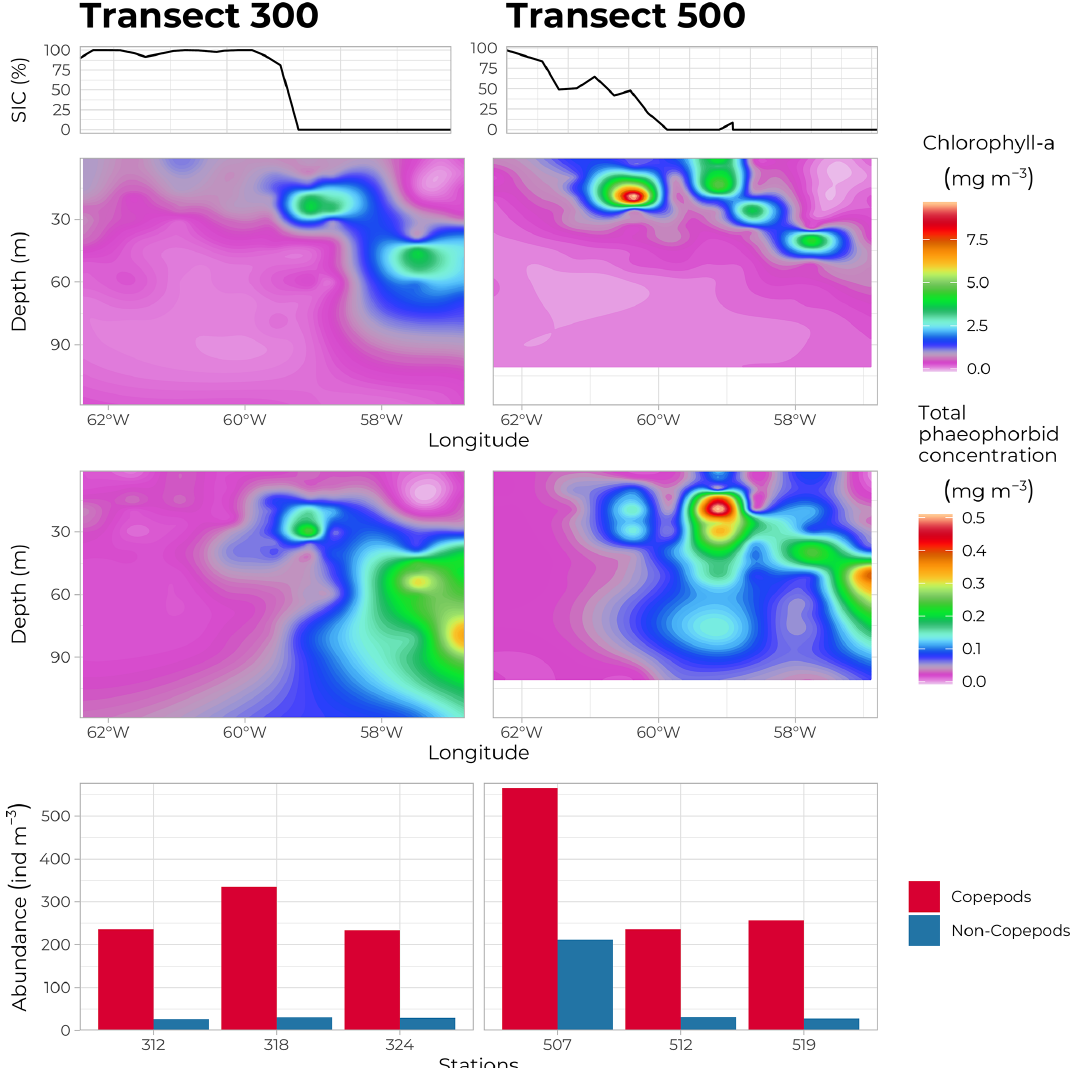
Figure 13. Water column chlorophyll a concentration (mgm − 3 , top panels) and total phaeophorbide a concentration (mgm − 3 , bottom panels) along transects 300 (69 ◦ N, left panels) and 500 (70 ◦ N, right panels), as measured by HPLC on discrete samples obtained from the Niskin bottles at every FULL and BASIC station. Bottom panels: abundance of zooplankton (indm − 3 ), copepods in red and non-copepods in blue, at each of the three FULL stations sampled on each transect (lower station numbers towards the east). The top graphs indicate the SIC at each station at the time of